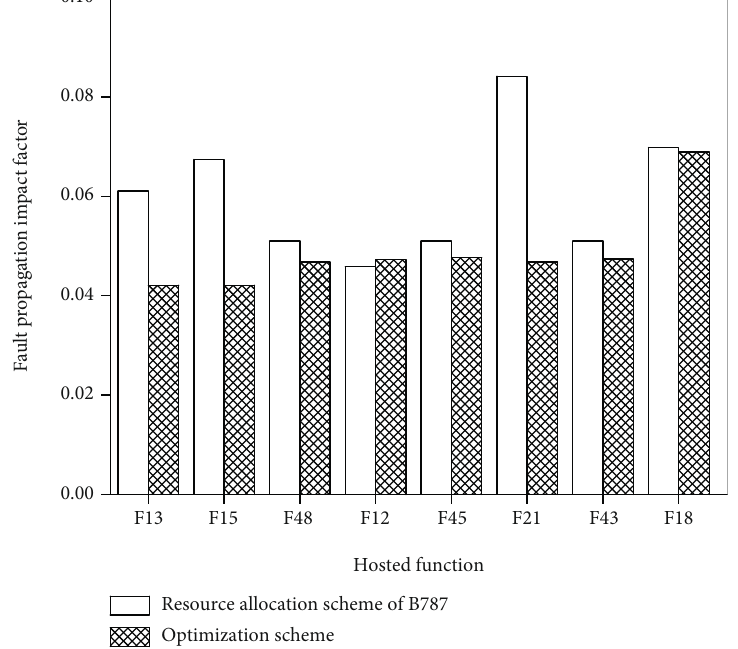
Figure 7: Fault propagation impact factor for resource module servicing key function.